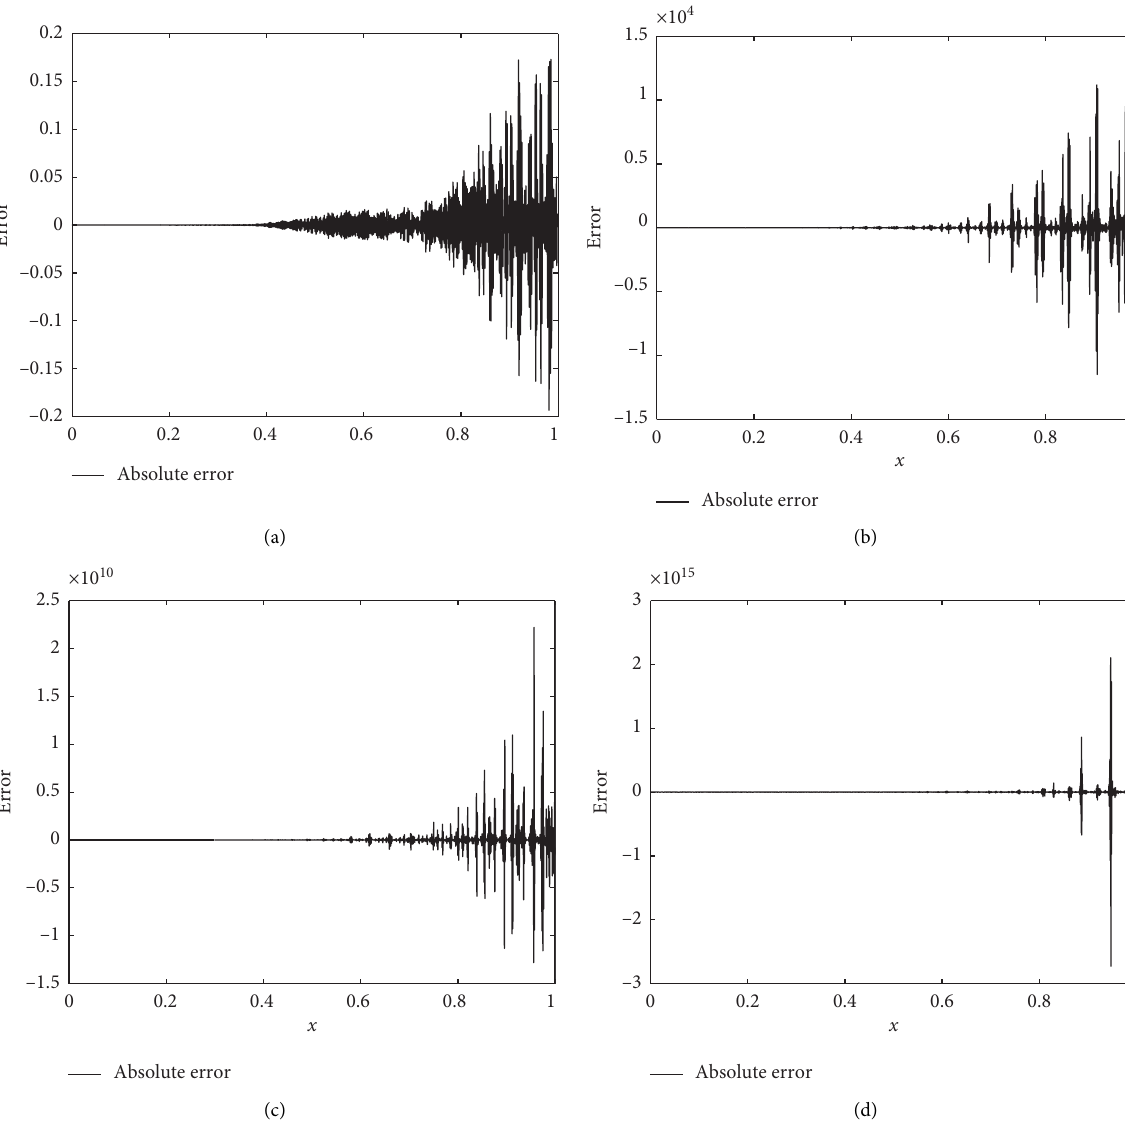
Figure 1: Absolute error of Example 1 with the forward Euler method and WENO5 scheme for different CFL numbers at T � 0 . 1 , N � 2560 , and α � 0 . 9. (a) σ � 0 . 3, (b) σ � 0 . 5, (c) σ � 0 . 8, and (d) σ � 1 .